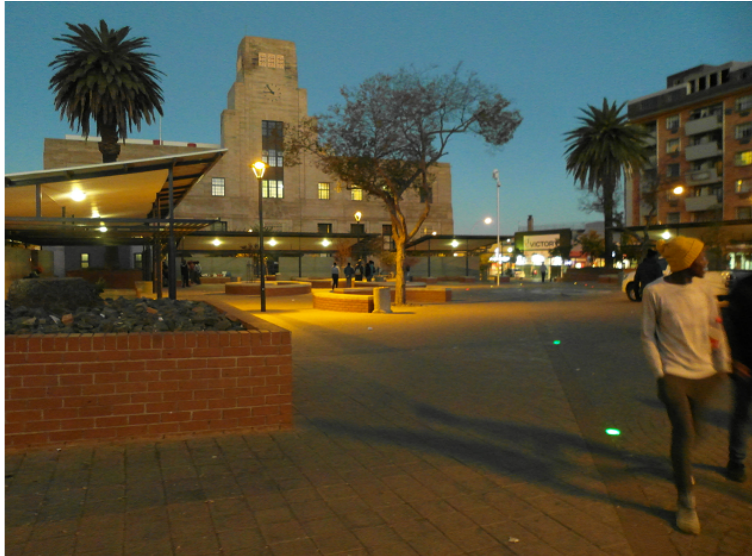
Figure 4. Night-time uses of Hoffman Square. Source: photograph by